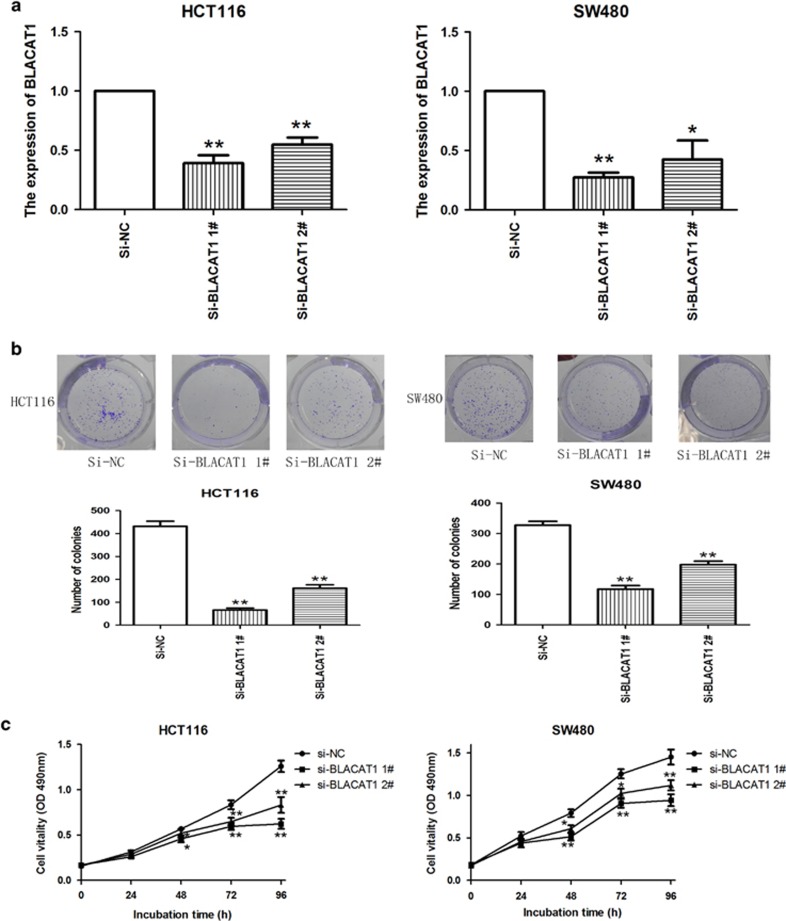
BLACAT1 regulates CRC cell proliferation in vitro. (a) The results of qPCR determined that the relative expression level of BLACAT1 decreased by transfection with si-BLACAT1 in CRC cells, compared with the transfection with si-NC. (b) A colony-formation assay revealed that BLACAT1 knockdown suppressed colony formation, compared with control cells. (c) MTT assays indicated that decreased BLACAT1 expression inhibited HCT116 and SW480 cells proliferation. *P<0.05, **P<0.01